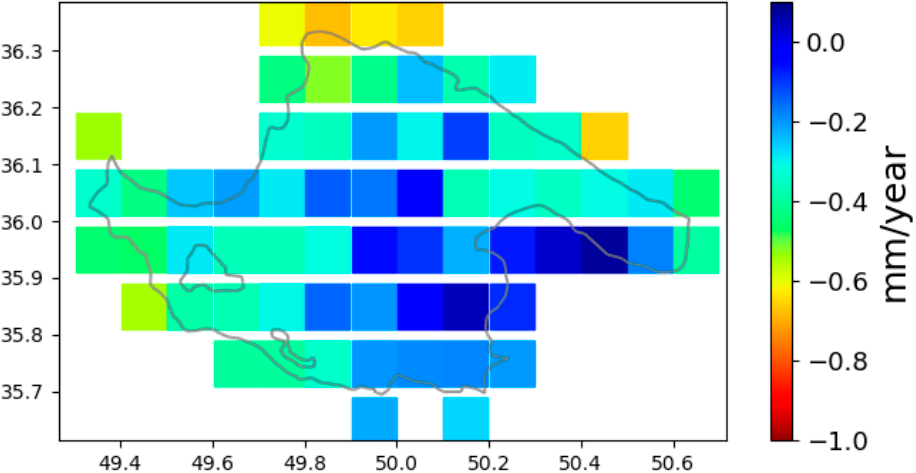
Figure 9. Qazvin Plain map of long-term GWSA trend in terms of equivalent water thickness (EWT) in mm/year for the WGHM-based GWSA 0.1 (time period is April 2002 to December 2016).